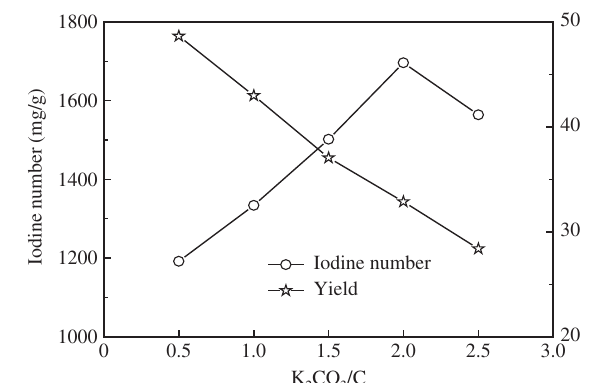
Figure 2: Effect of microwave power on iodine number and yield of high surface area activated carbon (HSAAC).